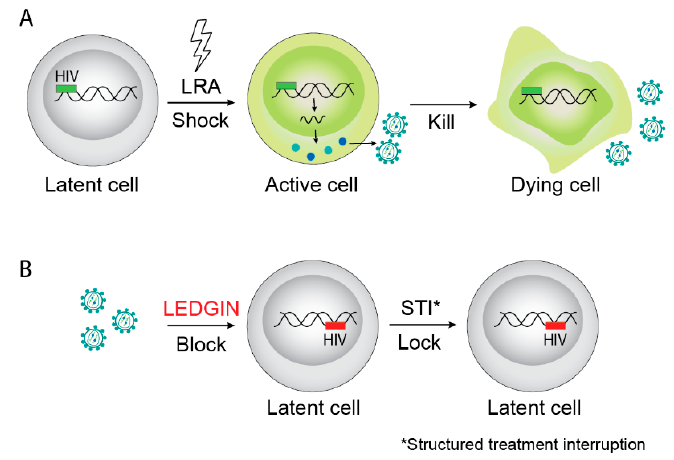
Figure 1. Examples of HIV cure strategies. ( A ) The “shock-and-kill” strategy aims to reactivate latent provirus followed by killing of activated cells by viral cytopathic effects on the host immune system. ( B ) The “block-and-lock” functional cure strategy aims to permanently silence latent reservoirs, for instance by LEDGIN-mediated retargeting of integration to sites that are less susceptible to reactivation after interruption of combination antiretroviral therapy (cART). LRA is